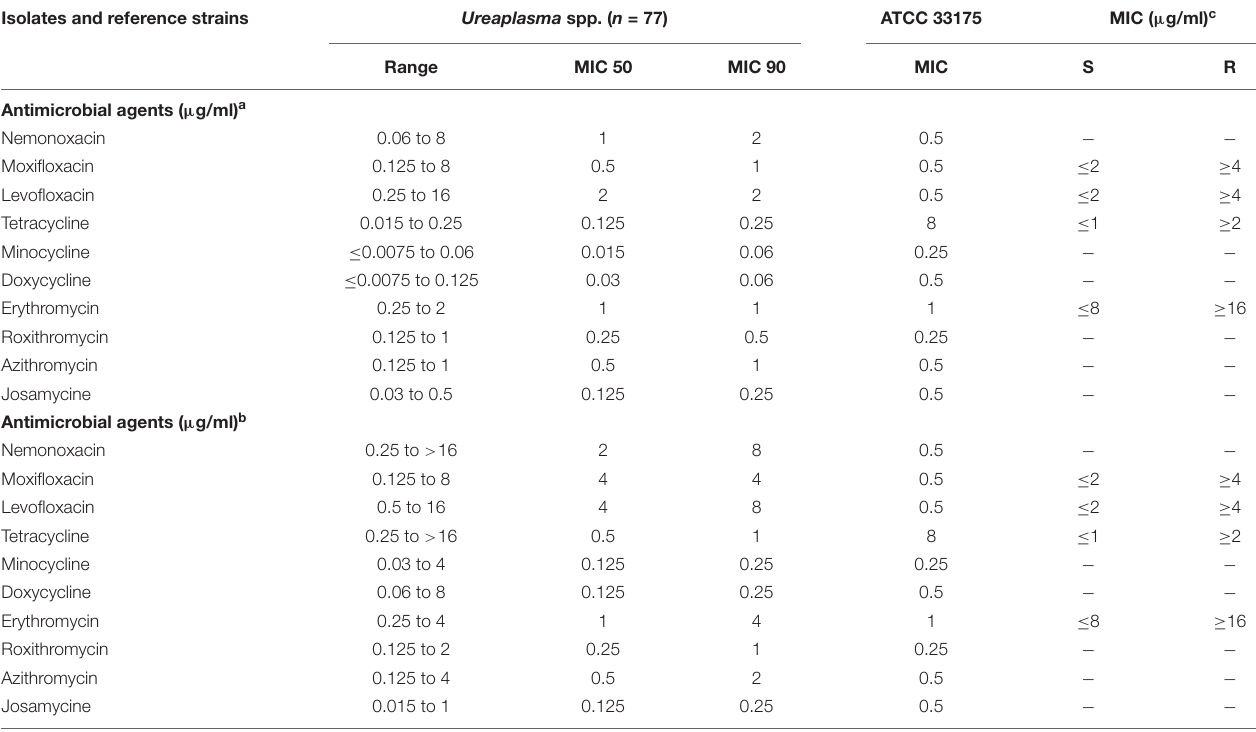
TABLE 4 | Minimal inhibitory concentration summary for nemonoxacin and the comparator agents. Isolates and reference